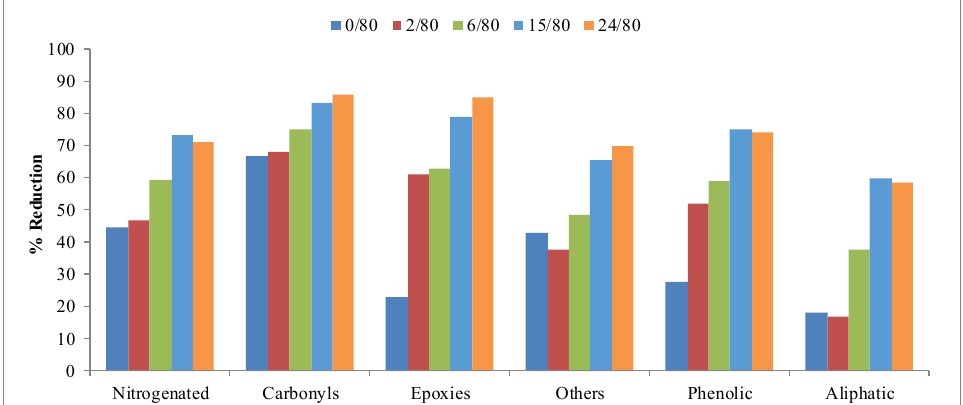
Figure 12. Reduction obtained for the different families of compounds in the total particular matter collected in the study of the hydrothermal treatment time.